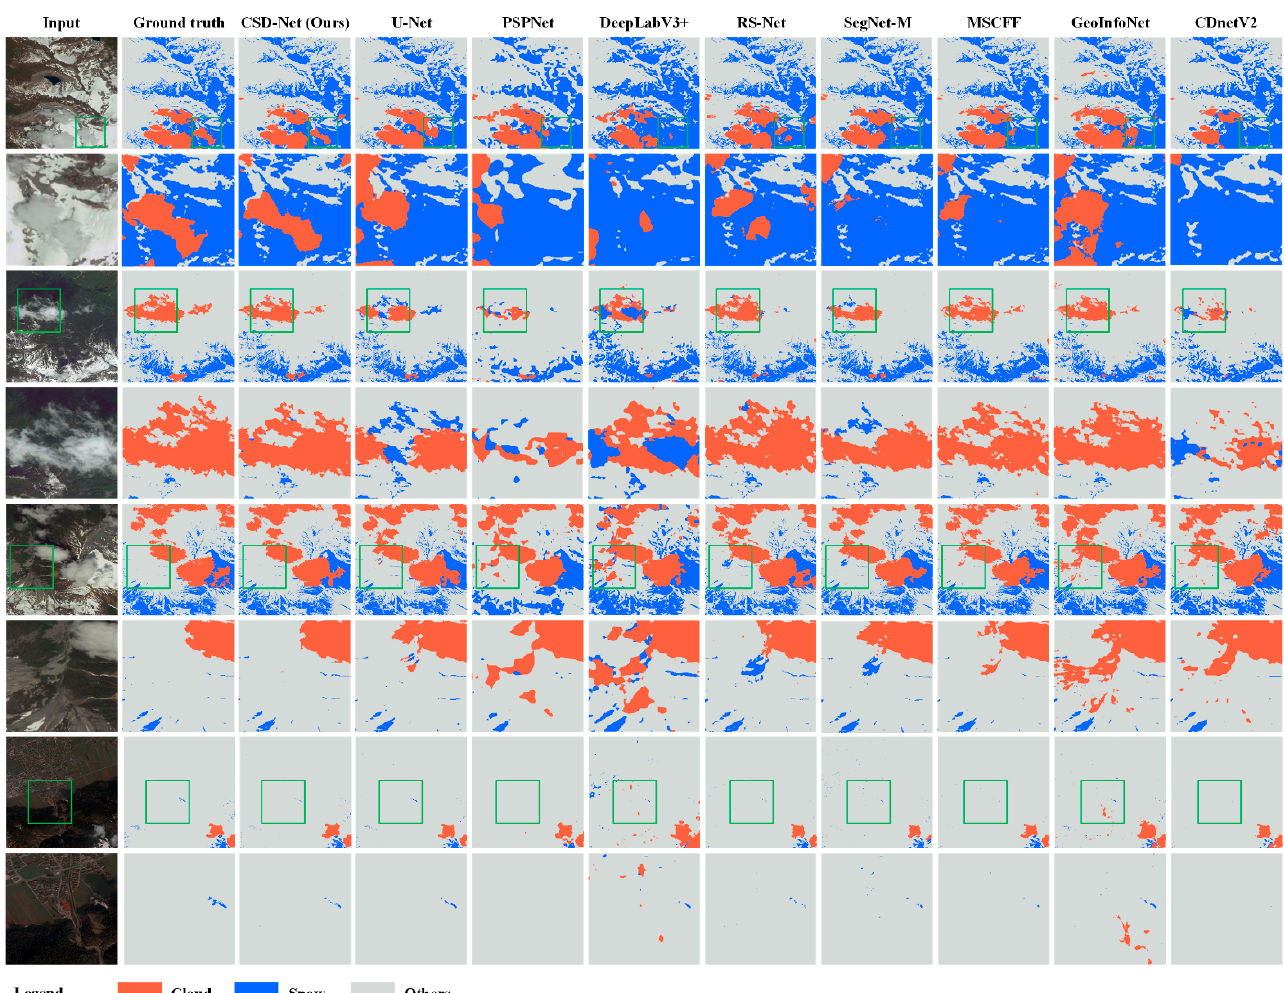
Figure 11. On the CSWV_M21 dataset, the visual comparison of cloud and snow detection results for several deep learning methods. It lists the original images, the detection results of various methods, and the ground truths one by one. The delineated areas with the green boxes were magnified to provide a more detailed visual comparison.